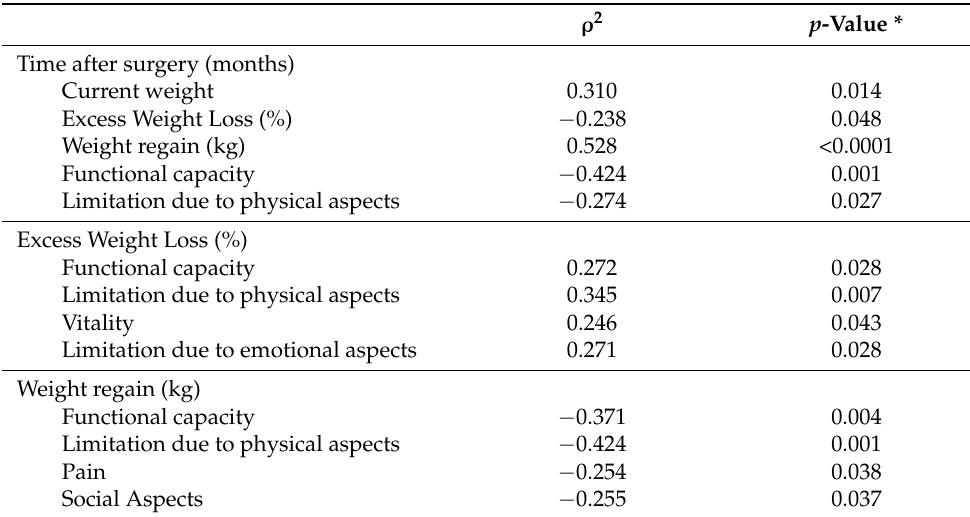
Table 3. Correlation between time after surgery, quality of life, eating behavior, and anthropometry of women with more than 24 months of bariatric